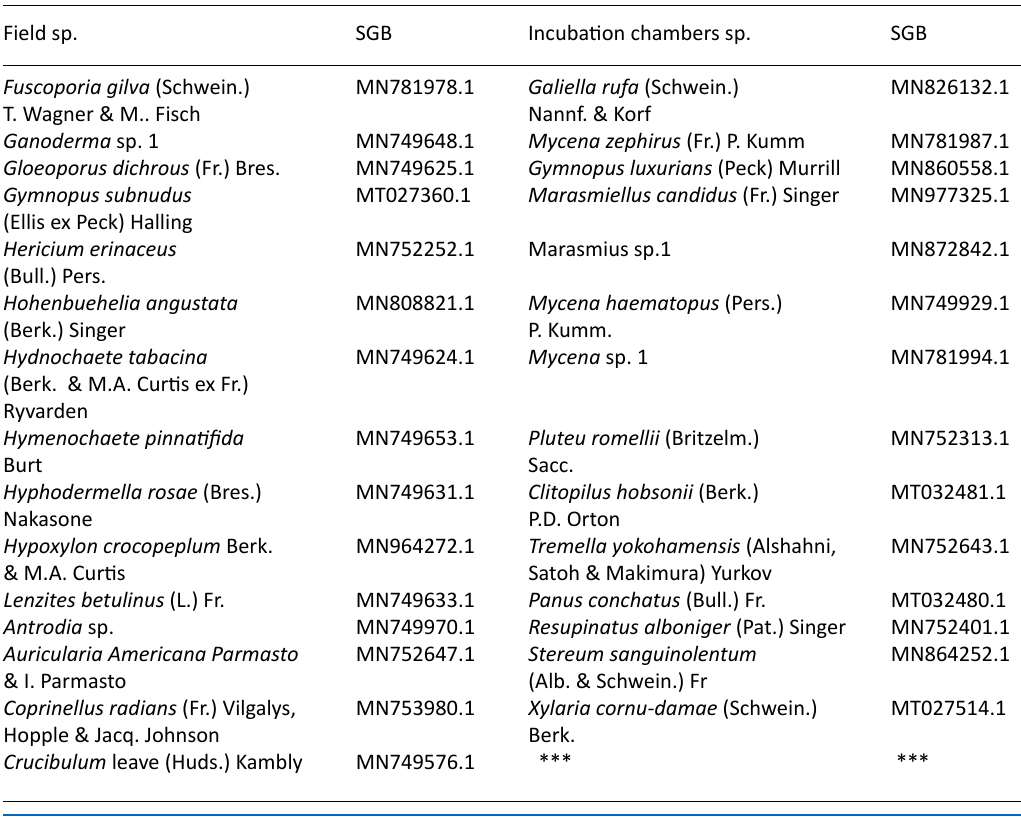
Table 1. Species of fungi recovered from different substrates from the field and the incubation chambers Field sp. SGB Incubation chambers